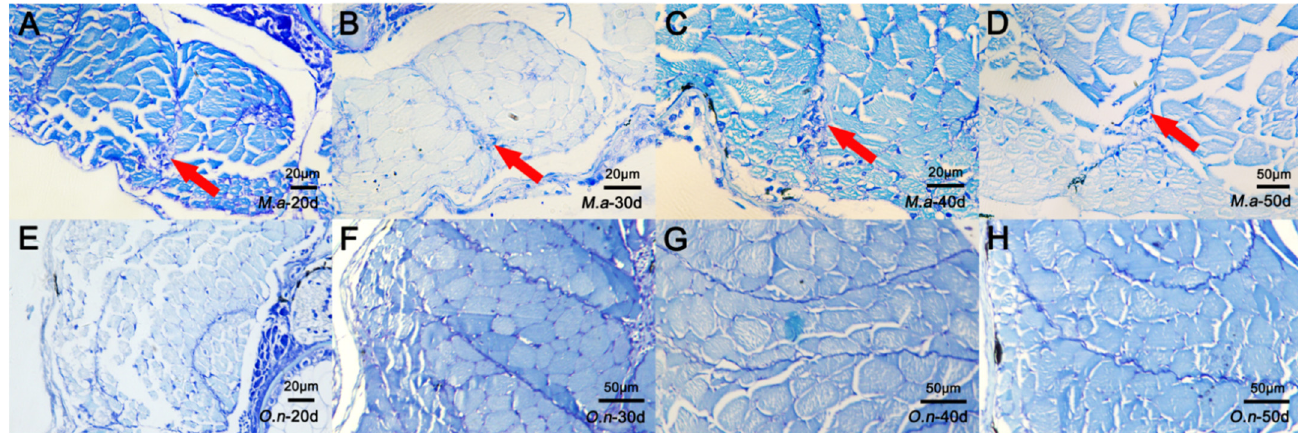
Figure 2. Histological characteristics during IB development based on toluidine blue staining in M. amblycephala and O. niloticus . ( A – D ) Staining at 20, 30, 40, and 50 dph of M. amblycephala ; ( E – H ) staining at 20, 30, 40, and 50 dph of O. niloticus . The IBs in M. amblycephala are marked by red arrows. No IBs were identified in O. niloticus .